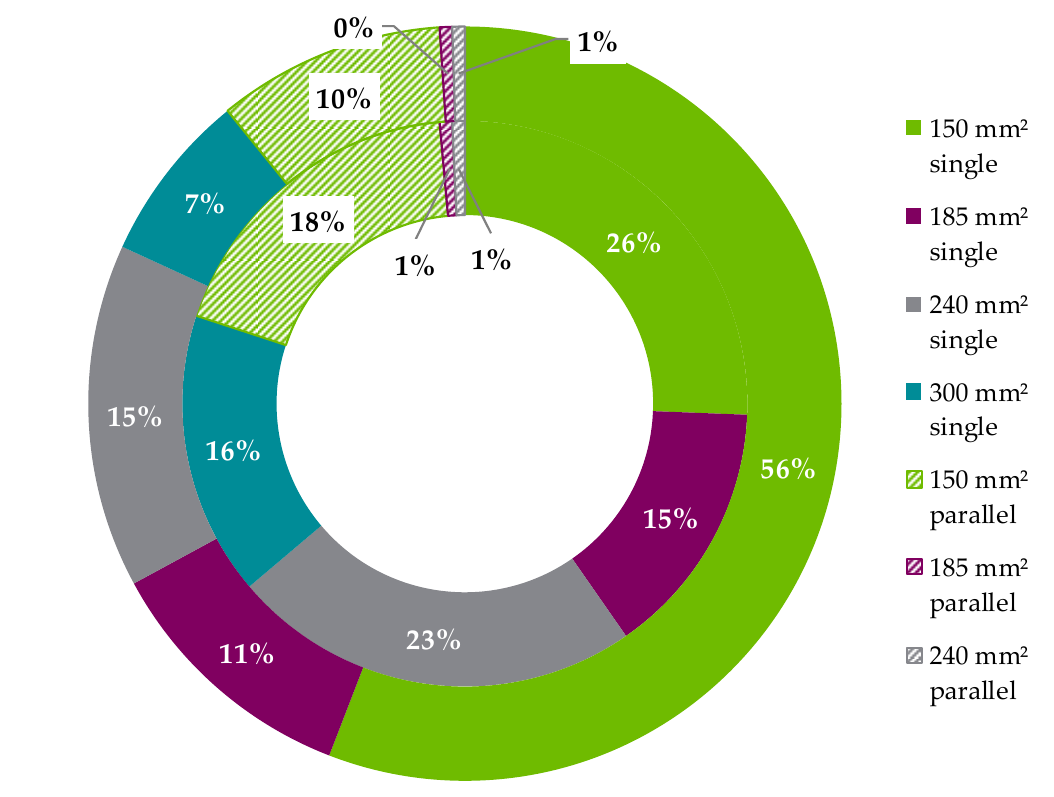
Figure 14. Share of cable measures for different cable cross-sections in relation to total cable measures for two planning techniques in the 10 kV grids.